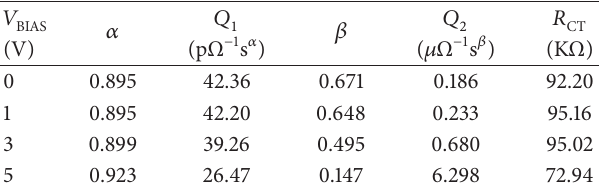
Table 2: Best fitting values of parameters in (2) for gelatin/graphene blend based devices.